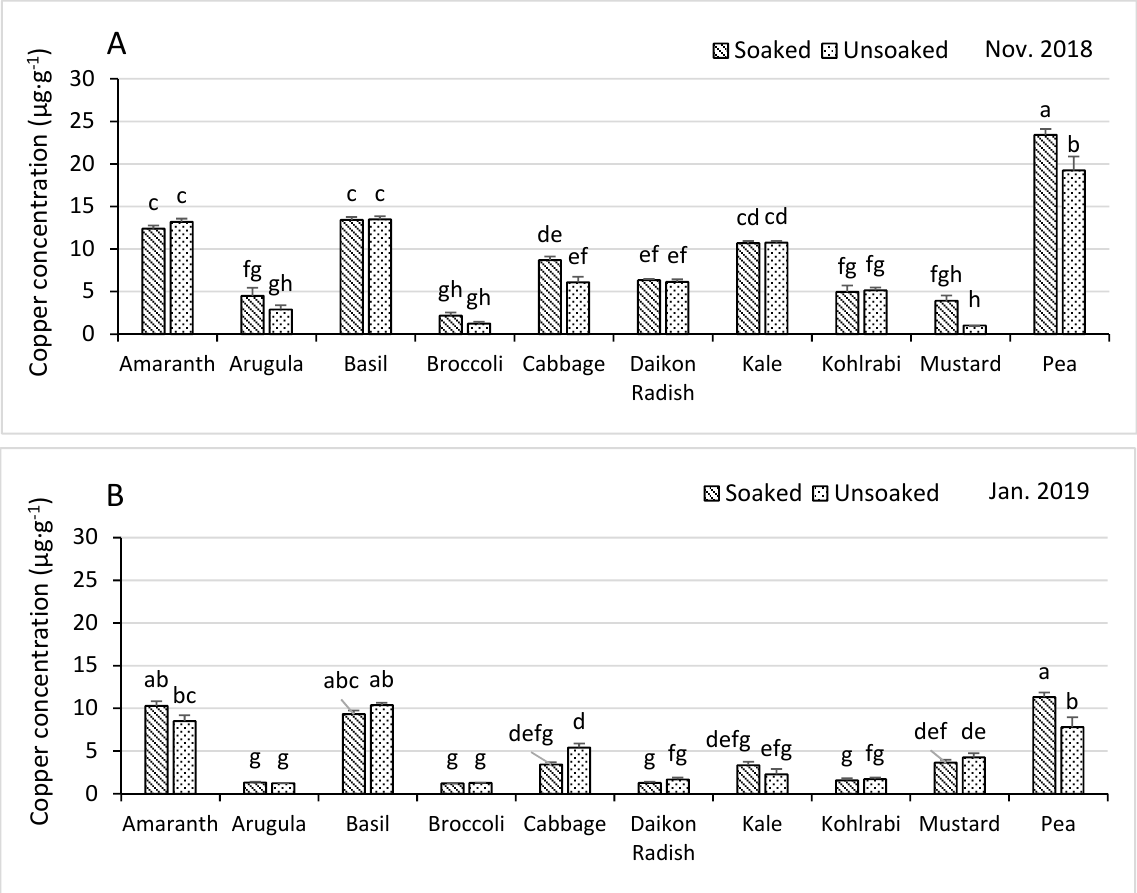
Figure 5. Copper concentrations on a dry weight basis in ten microgreens affected by the interaction between species and seed soaking in November 2018 ( A ) and in January 2019 ( B ). Means with standard error bars of each species were obtained by averaging data from both fertilization treatments. Different lowercase letters within a chart suggested significant difference among treatments combinations indicated by Tukey’s HSD test at α ≤ 0.05.